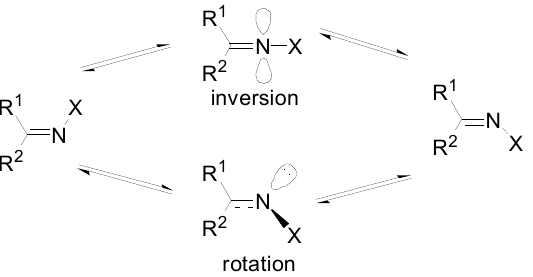
Figure 1. Two possible mechanisms of the Z/E-isomerization of imines.